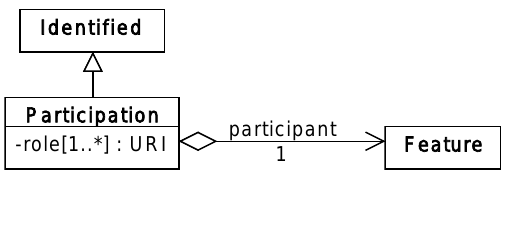
Figure 13: Diagram of the Participation class and its associated